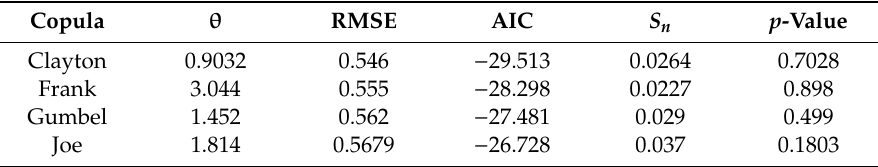
Figure 4. ( a , b ) The comparison of observed data (black dots) and 10,000 random pairs generated data (blue dots) from the copula for peak-flow and volume. ( c ) The QQ-plot of the copula (Kendall function from the data and the copula). ( d ) The comparison between empirical and theoretical copula. Table 5. Estimated value of the copula parameter ( θ ), RMSE, AIC and Crammer-von Misses goodness-of-fit test ( S n ) and p -values based on parametric bootstrap